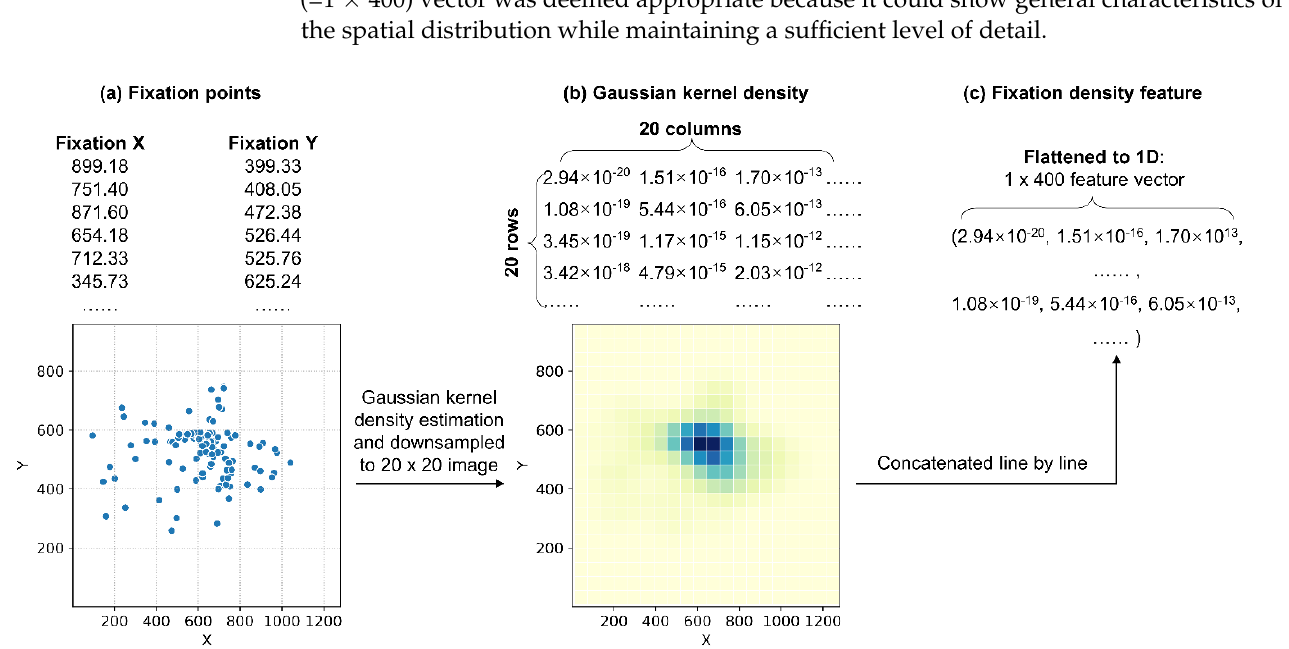
Figure 3. Calculation of fixation density features. ( a ) Fixation points; ( b ) Gaussian kernel density estimation; and ( c ) fixation density